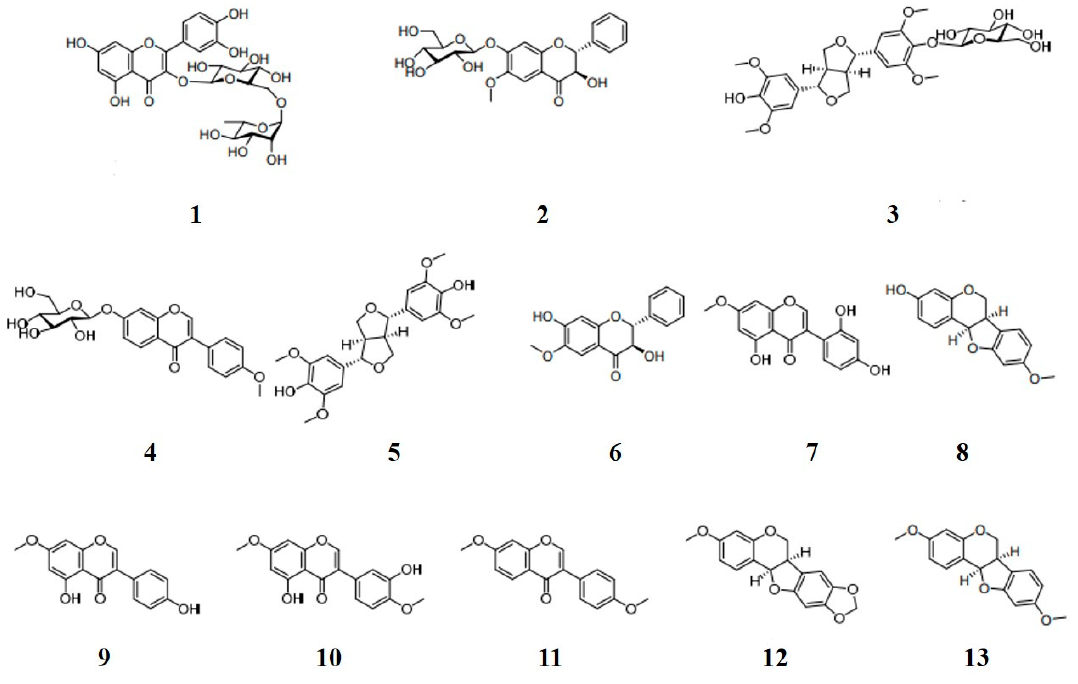
Figure 1. Chemical structures of compounds 1 – 13 isolated from the Canavalia lineata ; rutin ( 1 ), (2 R ,3 R )-3-hydroxy-7- O - D -glucopyranoside-6-methoxy-flavanone ( 2 ), (–)-syringaresinol-4- O - β - D - glucopyranoside ( 3 ), ononin ( 4 ), syringaresinol ( 5 ), (2 R ,3 R )-3,7’-dihydroxy-6-methoxy-flavanone ( 6 ), cajanin ( 7 ), medicarpin ( 8 ), prunetin ( 9 ), 7,4’-dimethyl-3’-hydroxygenistein ( 10 ), 7,4’-dimethoxyisoflavone ( 11 ), pterocarpin ( 12 ), and homopterocarpin ( 13 ).